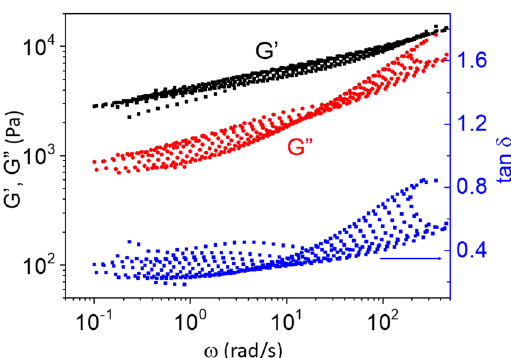
Figure A5: Master curve of ( S 15.4 - 0.21 - B 46.6 ) 3 with G ′ , G ″ , and tan δ versus angular frequency ( ω ) with the reference temperature at 150°C.